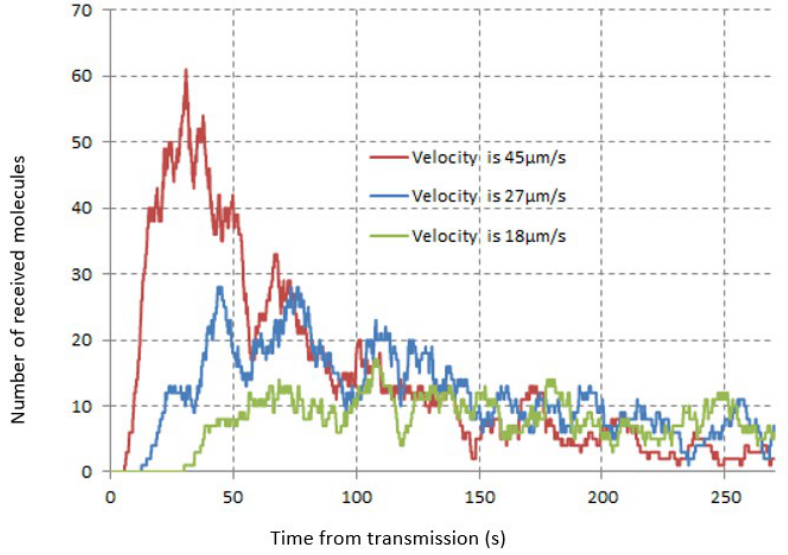
Figure 3. Different velocities for the same BS–node configuration. The red line represents the signaling molecules with a speed of 45 µ m/s, the blue line a speed of 27 µ m/s and the green line a speed of 18 µ